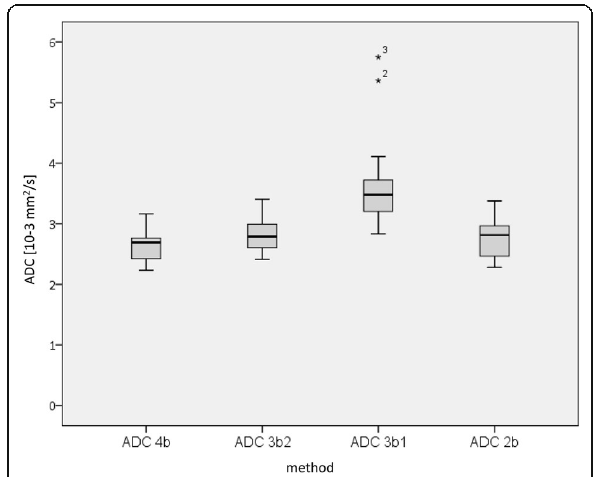
Fig. 1 Boxplots of absolute ADC values calculated from different b value combinations: 4b = 0, 100, 200, 300 s/mm 2 , 3b2 = 0, 200, 300 s/